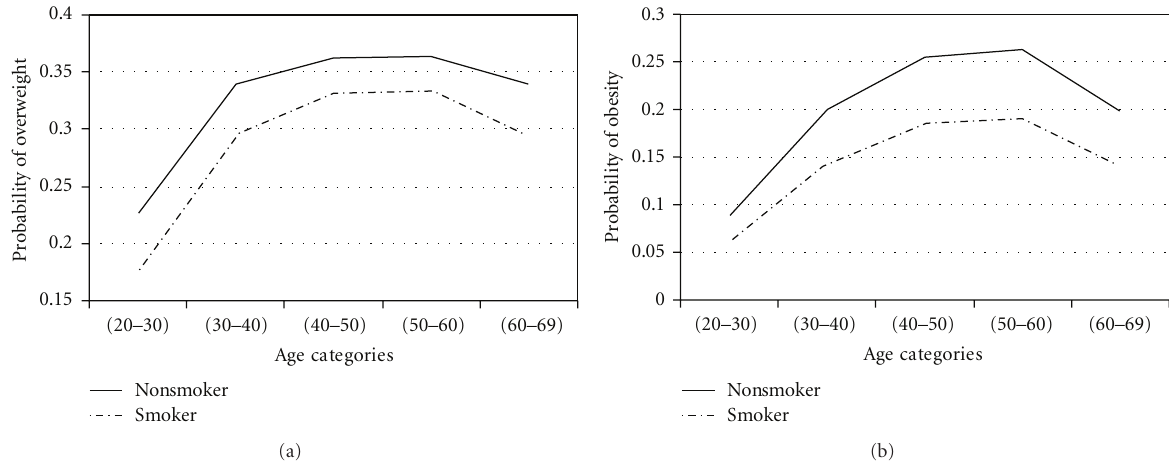
Figure 5: Probabilities of overweight and obesity across age groups for smoking status.